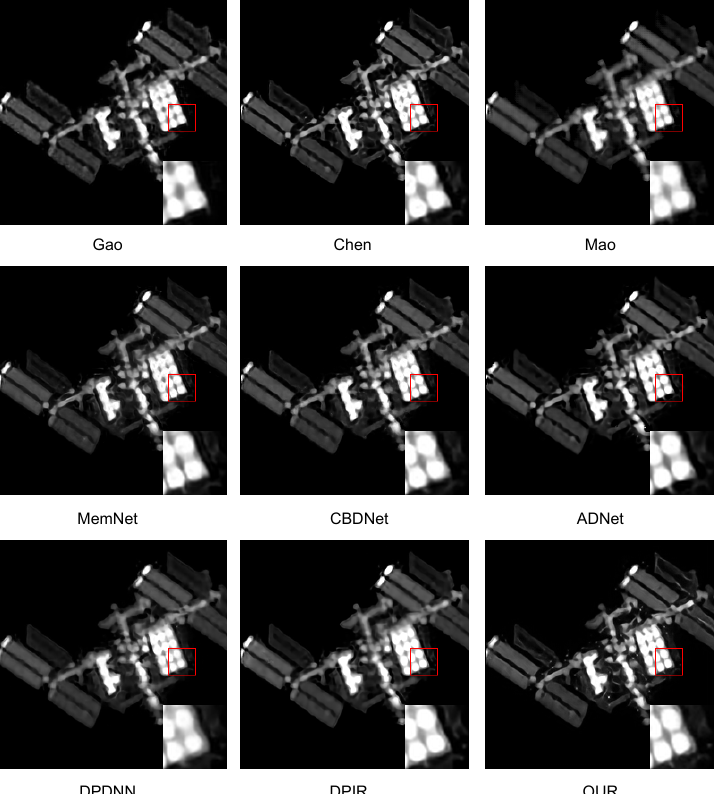
Figure 15. Restoration using different methods on real turbulence blur (The red boxes represent the focus